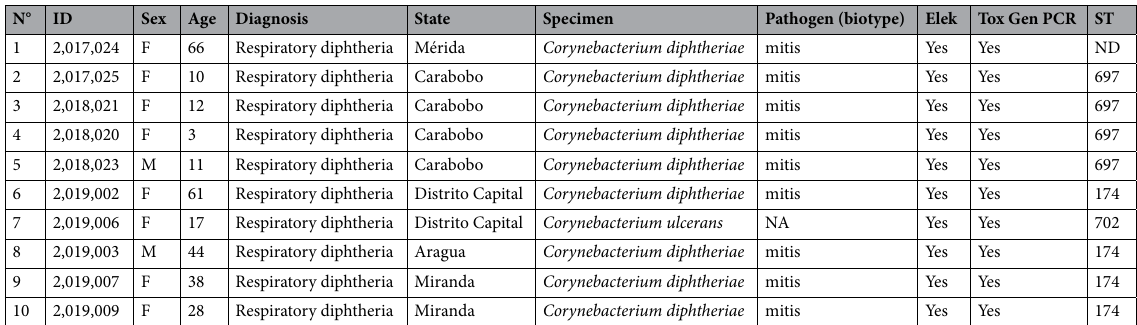
Table 3. Characteristics of the C orynebacterium isolates. ND not defined, NA not applicable, ND no